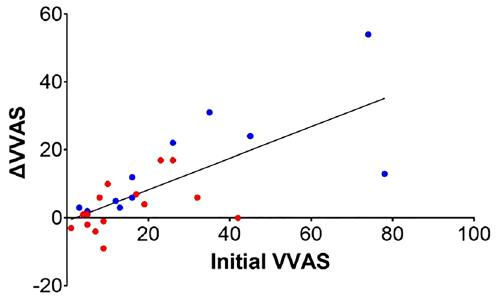
Figure 3. The change in VVAS after the 4-week program (ΔVVAS = VVAS at baseline—after 4 weeks, a negative value indicates aggravated visual vertigo) was correlated with VVAS at baseline in the VE group (blue dots, Spearman’s ρ = 0.881, p < 0.001) and the VE + OS group (red dots, Spearman’s ρ = 0.544, p = 0.036). The change in the VVAS score of all participants was correlated with the initial visual vertigo symptom (Pearson’s ρ = 0.716, p < 0.001, R 2 =